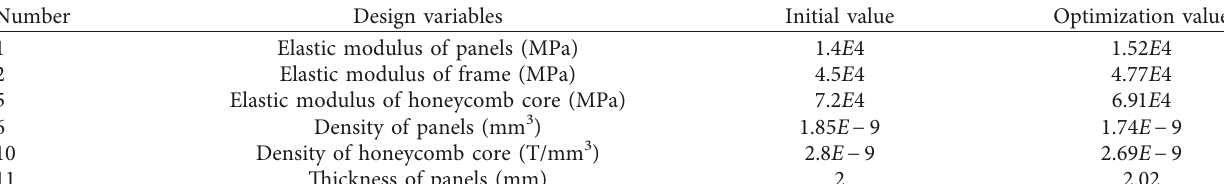
Table 4: Comparison of initial and optimized values of model elastic parameters and